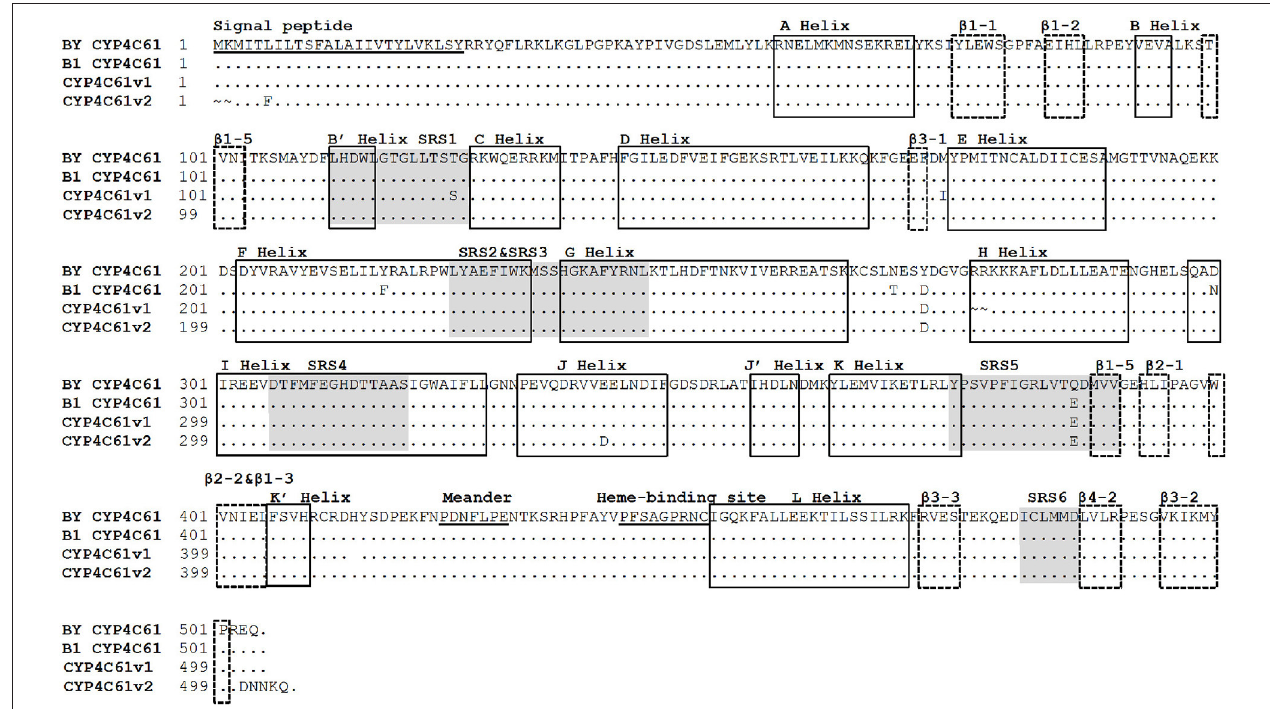
FIGURE 7 | Alignment of amino acid sequences of the biotype Y CYP4C61 protein and other BPH CYP4C61 proteins. BY CYP4C61: Biotype Y CYP4C61; B1 Biotype 1 CYP4C61; CYP4C61v1: amino acid sequences from GenBank: FM163384.1; CYP4C61v2: amino acid sequences from GenBank: KM217037.1. The underlined sequences represent the signal peptide, meander and heme-binding regions. The shaded areas indicate the six substrate recognition sites (SRSs); α -helices and β -sheets are indicated by solid line boxes and broken line boxes,